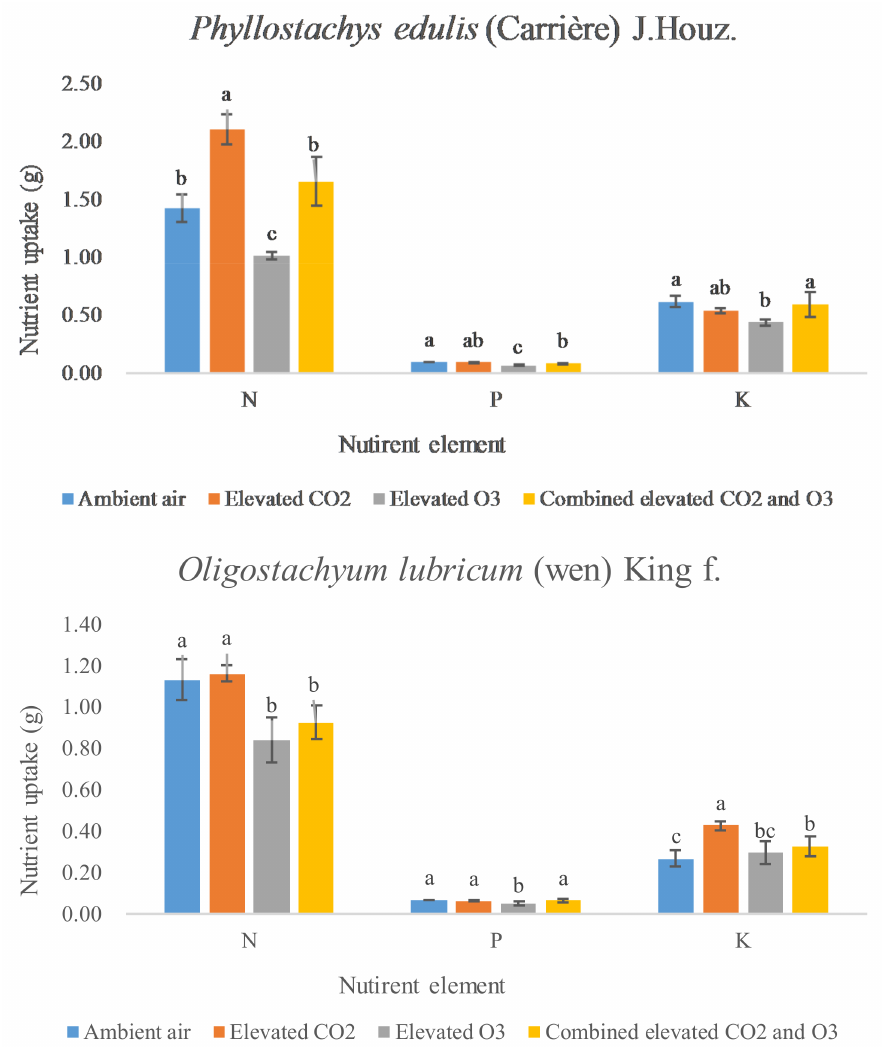
Figure 1. Leaf nutrient uptake (g) (mean ± s.d.) of Phyllostachys edulis and Oligostachyum lubricum in response to ambient air, elevated O 3 , CO 2 and combined elevated O 3 and CO 2 . Different letters indicate significant differences among treatments ( p <